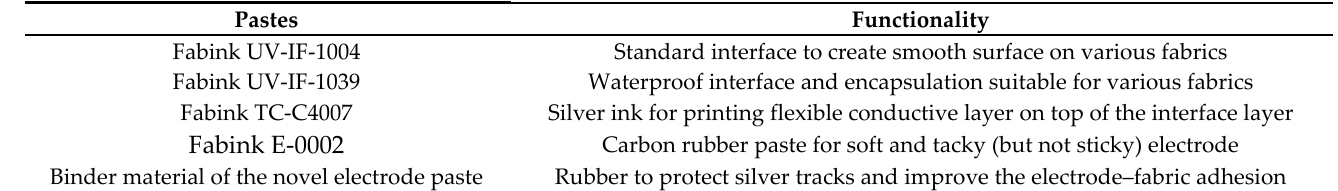
Table 1. Pastes and their functionality.